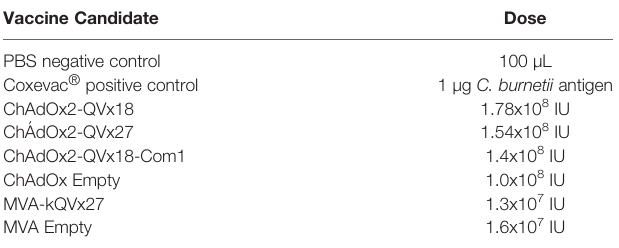
TABLE 3 | Challenge inoculations for reactogenicity testing in guinea pigs. Vaccine Candidate